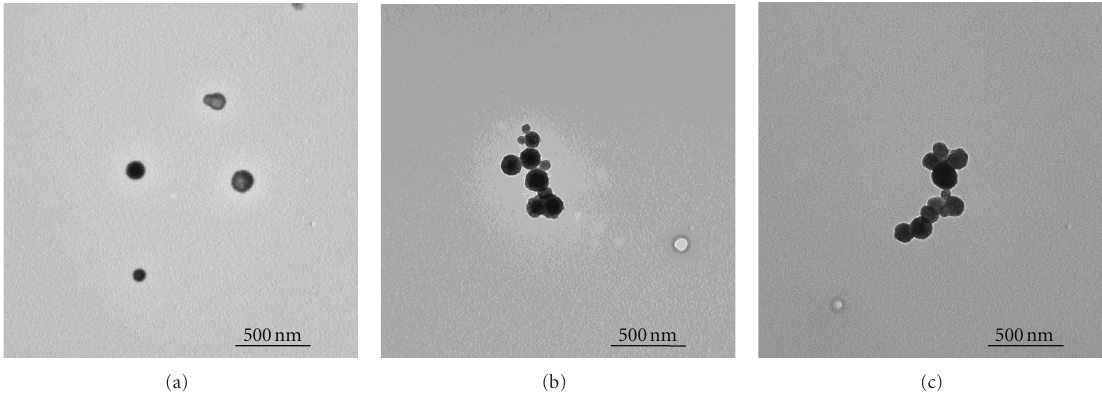
Figure 9: TEM images of copper particles at di ff erent lithium ion concentrations (a): 1.0 × 10 − 3 , (b): 3.0 × 10 − 3 , (c): 6.0 × 10 − 3 mol of Li ions, Cu ions conc.: 0.3 × 10 − 3